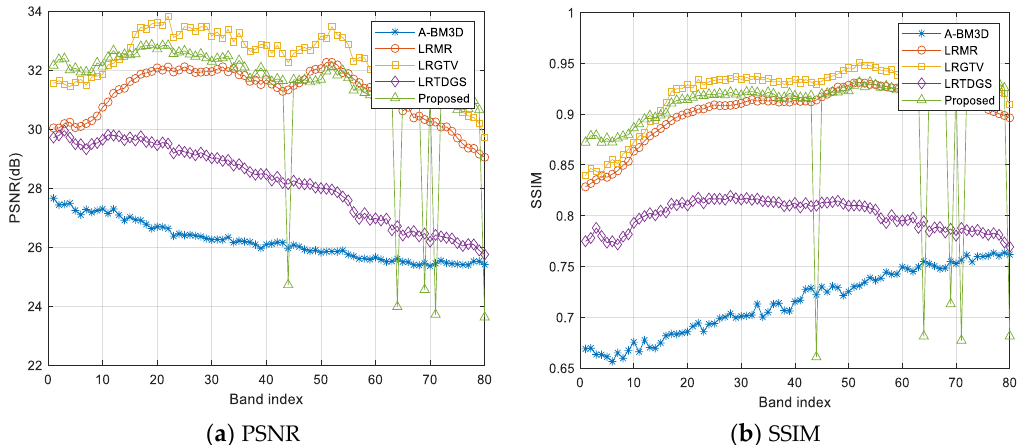
Figure 8. PSNR and SSIM values of restored results by different methods on Pavia data. (G = 0.10, S = 0.20).